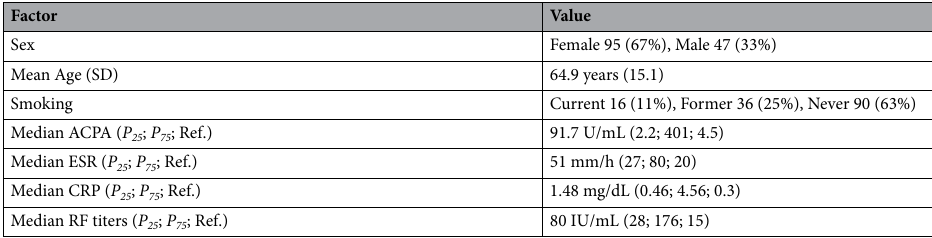
Table 1. Patient characteristics and clinical parameters. Data represent numbers (percentages), mean (SD), or median ( P 25 ; P 75 ). ACPA anti-citrullinated peptide antibody, CRP C-reactive protein, ESR erythrocyte sedimentation rate, RF rheumatoid factor, SD standard deviation. P 25 25th percentile, P 75 75th percentile, Ref. reference